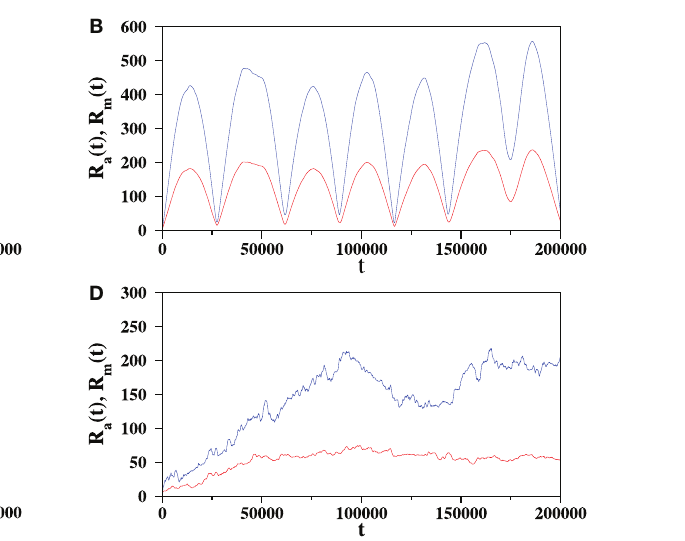
FIGURE 9 | Effect of noise is exhibited on a single flock ( N = 512 agents, each having n = 10 neighbors) which goes to a cyclic state without any noise. Variation of the maximal radius R m (blue) and the average radius R a